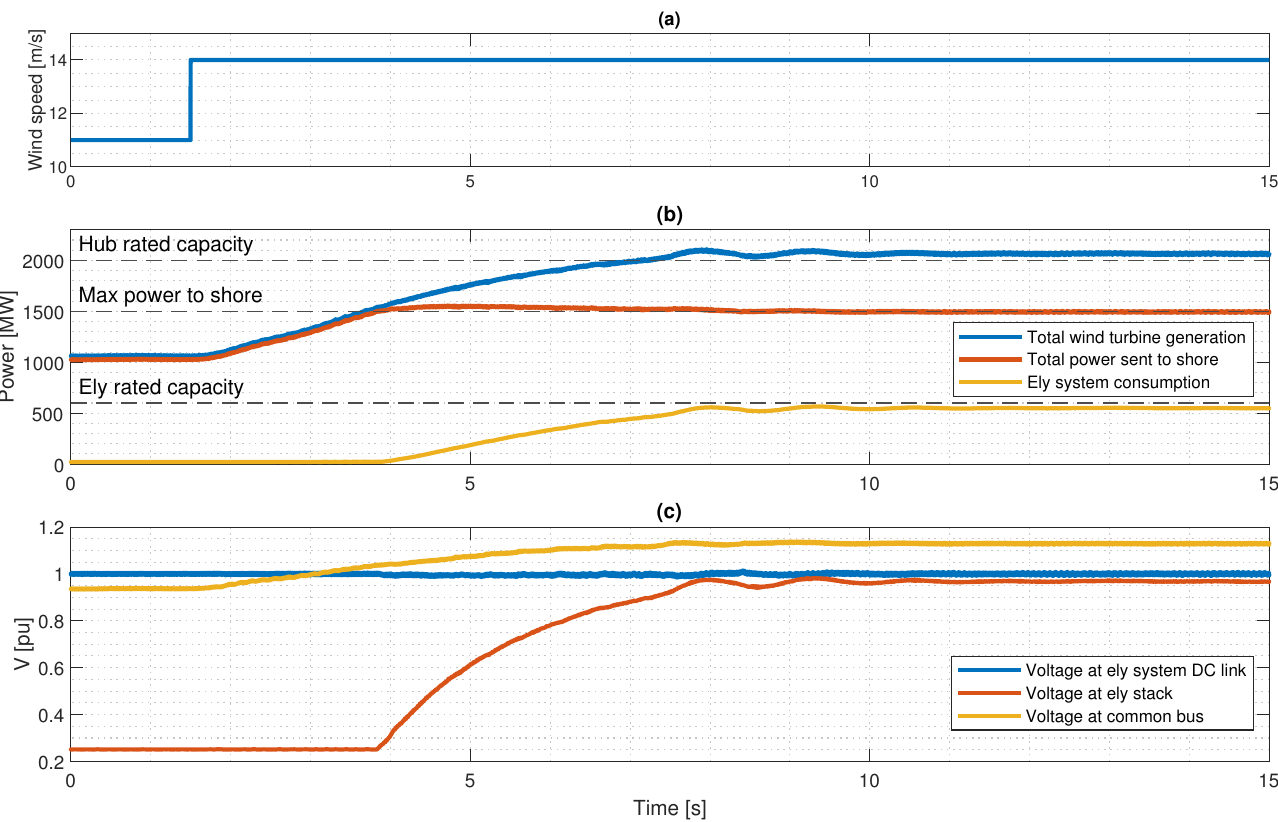
Figure 15. Time response of the electrolyser and common bus under wind speed step from 11 to 14 m/s. ( a ) Wind speed pattern. ( b ) Active power measurements. ( c ) Voltage